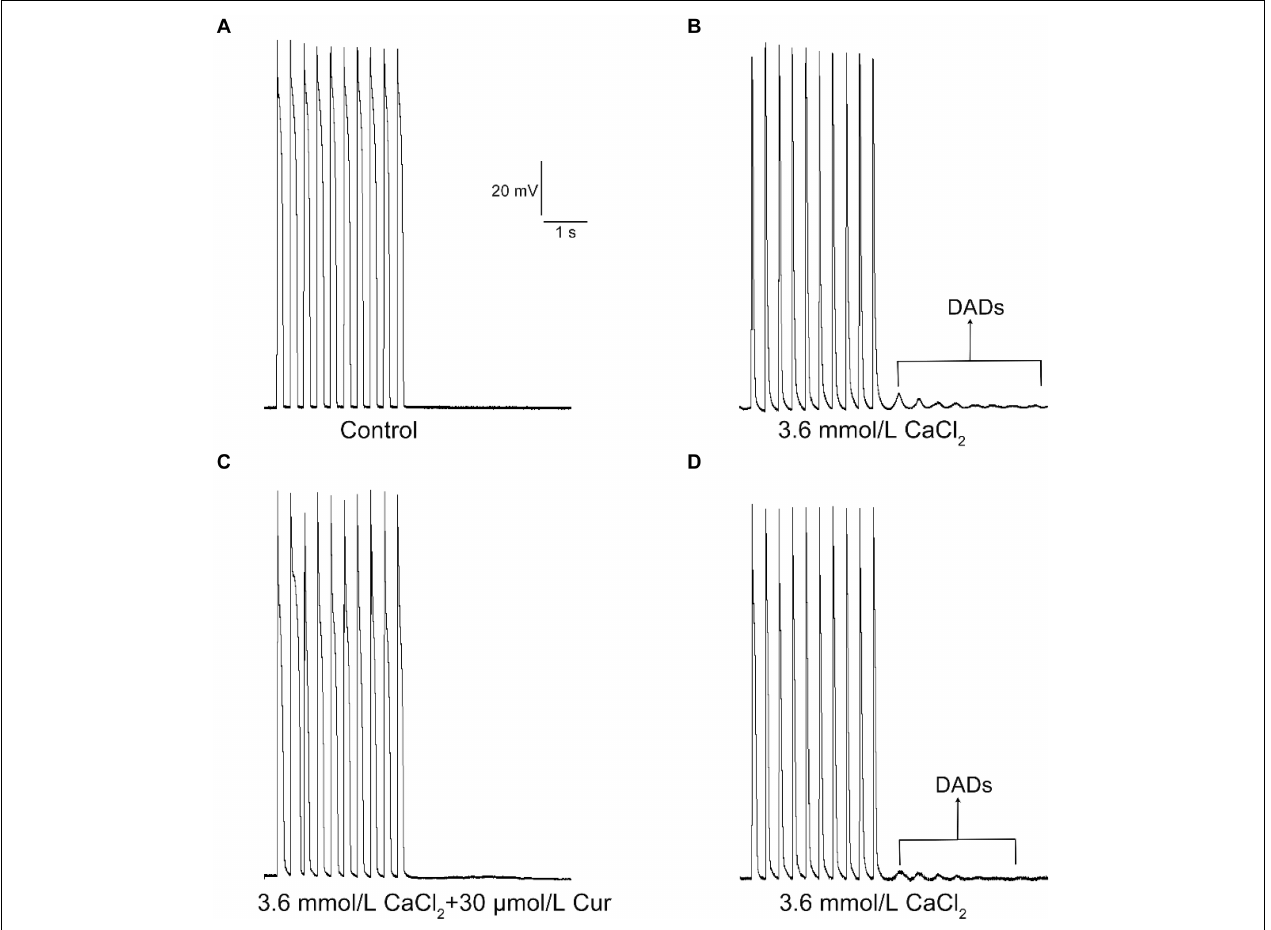
FIGURE 6 | The effects of Cur on delayed afterdepolarization (DAD) in ventricular myocytes. (A–D) Example records of APs with a train-of-10 stimulation at a higher frequency of 5 Hz, and the cycle length was 7 s. (A–D) Represent the control group, DAD group, Cur-treated group, and wash out group,